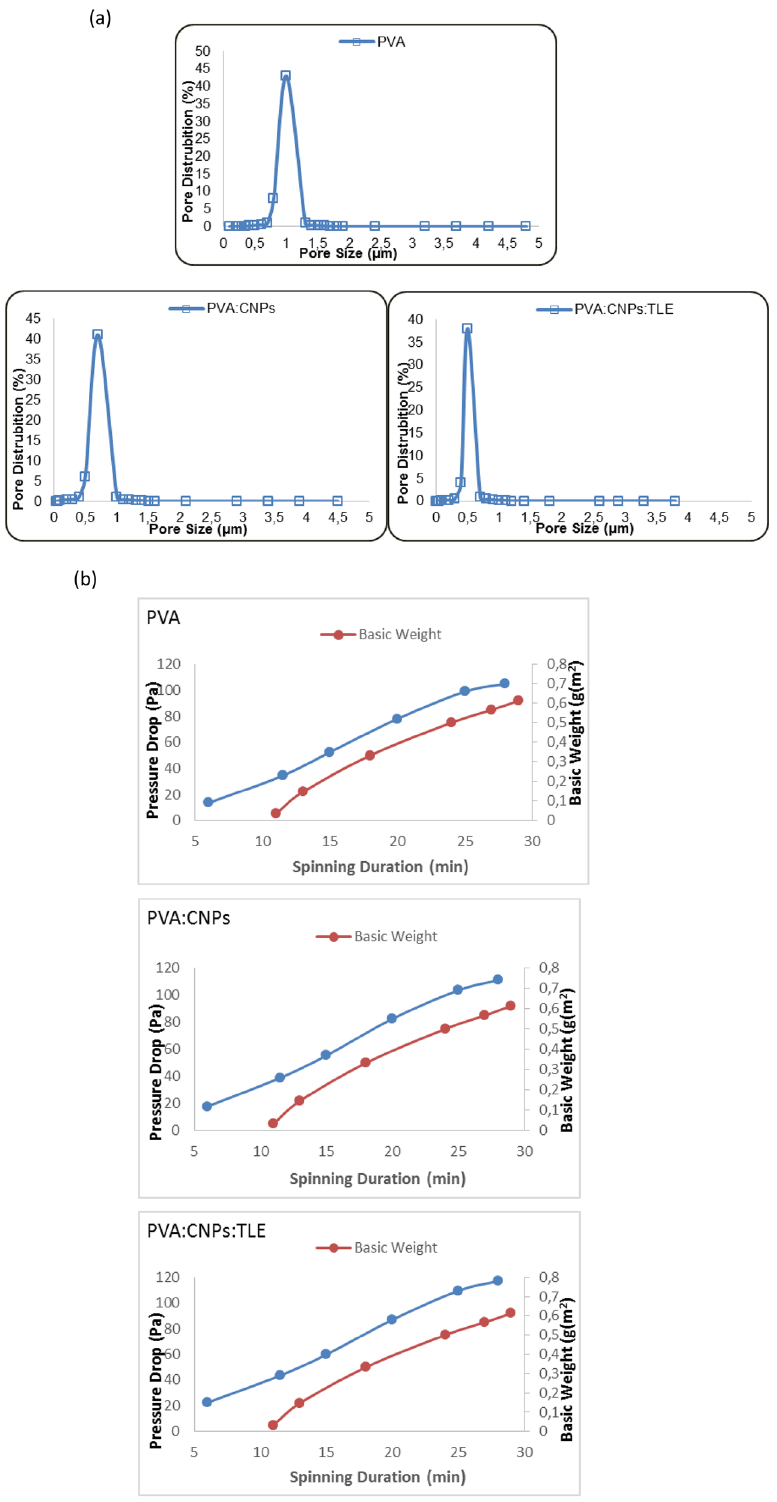
Figure 6. ( a ) Pore size distribution curve of PVA, PVA: CNPs and PVA: CNPs: TLE, ( b ) Pressure drop of PVA, PVA: CNPs and PVA: CNPs: